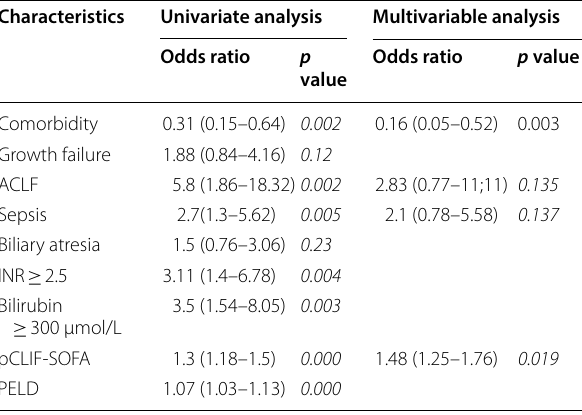
Table 4 Risk factors for mortality ( n ( n 97) on day-28 = Characteristics